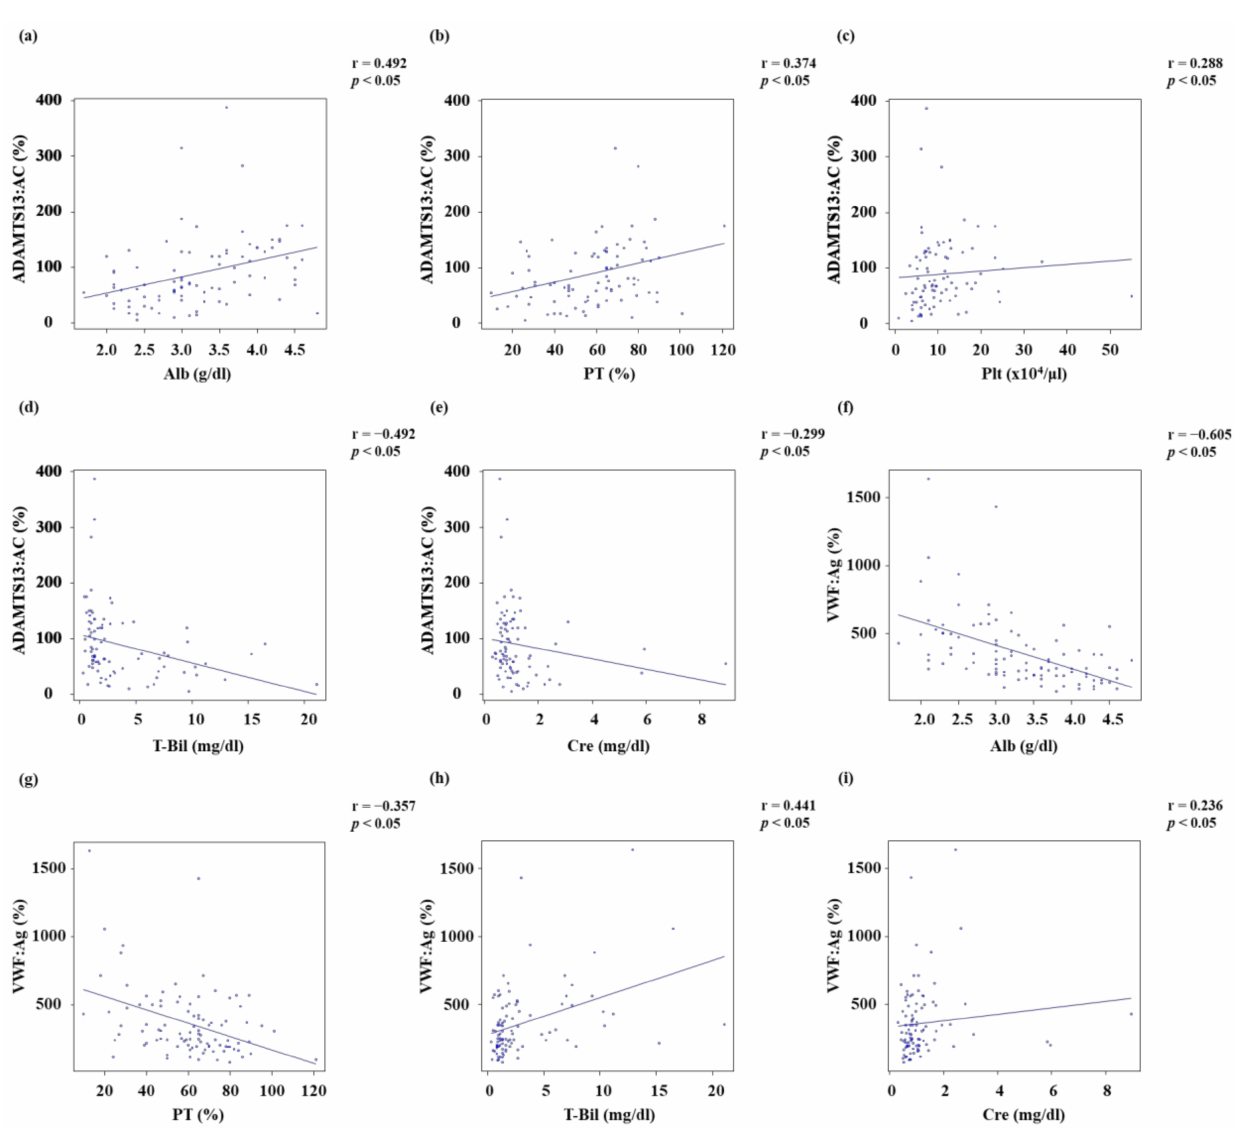
Figure 3. Relationship between ADAMTS13:AC or VWF:Ag and other parameters. ( a – c ) ADAMTS13:AC was directly correlated with Alb ( r = 0.492, p < 0.05), PT ( r = 0.374, p < 0.05), and Plt ( r = 0.288, p < 0.05). ( d , e ) ADAMTS13:AC was inversely correlated with T-Bil ( r = − 0.492, p < 0.05) and Cre ( r = − 0.299, p < 0.05). ( f , g ) VWF:Ag was inversely correlated with Alb ( r = − 0.605, p < 0.05) and PT ( r = − 0.357, p < 0.05). ( h , i ) VWF:Ag was directly correlated with T-Bil ( r = 0.441, p < 0.05) and Cre ( r = 0.236, p < 0.05). Alb, albumin; PT, Prothrombin time; Plt, Platelet count; T-Bil, Total bilirubin; Cre, Creatinine; ADAMTS13, a disintegrin-like and metalloproteinase with thrombospondin type 1 motifs 13; ADAMTS13:AC, ADAMTS13 activity; VWF, von Willebrand factor; VWF:Ag, VWF